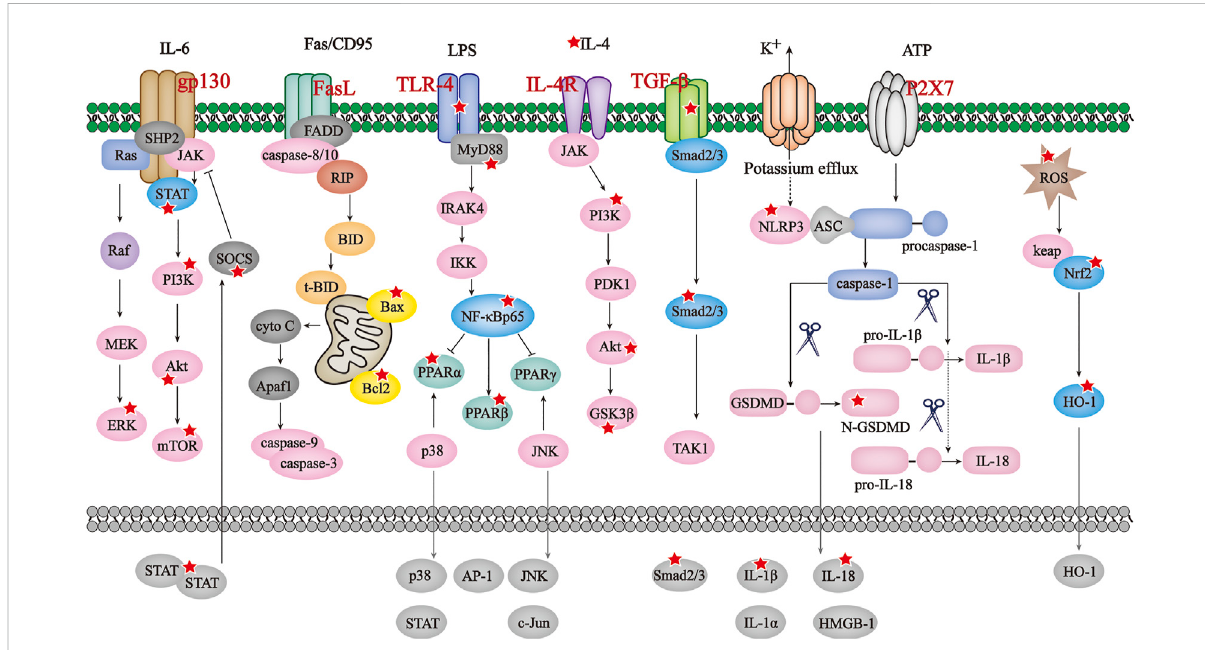
FIGURE 2 Theprincipalpathwaysmodulated bySBGanditscompoundsinADS.JAK/STAT/mTOR,BAX/Bcl2/caspase-3/9, TLR4/NF- κ B/PPAR,IL-4/PI3K/ Akt/GSK3 β , TGF- β /Smad2/3,NLRP3/caspase-1/GSDMD and ROS/Nrf2/HO-1 pathways are the principal signaling modulated by SBG and its compounds in ADS. The reported molecules regulated by SBG are marked with a red